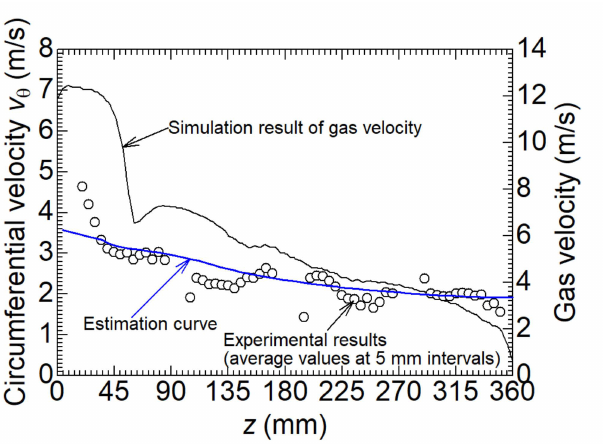
Figure 12. Variations in estimated and experimental circumferential velocity v θ and simulated gas velocity along the z-